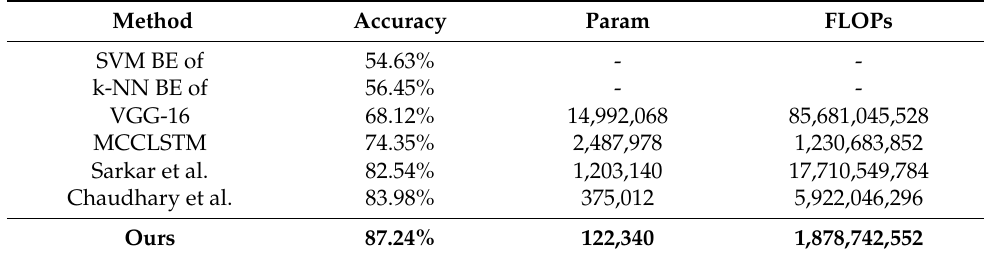
Table 7. On Soundtrack datasets, the result present as bold.